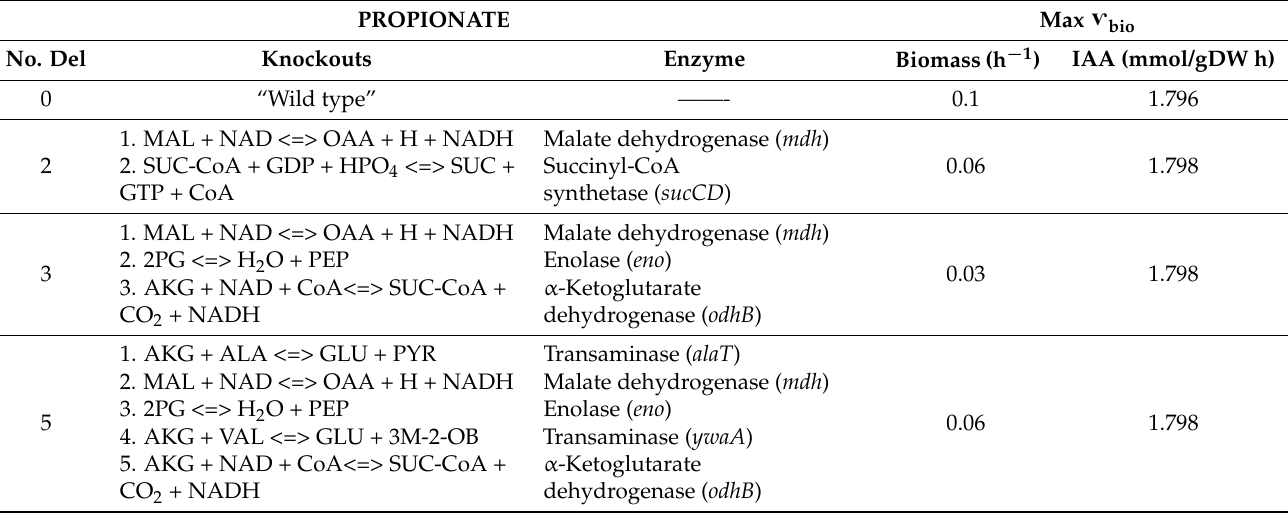
Table 2. Sets of candidate reactions to be deleted with potential increase in the production of IAA Table 2. Cont. while maintaining optimal biomass production.